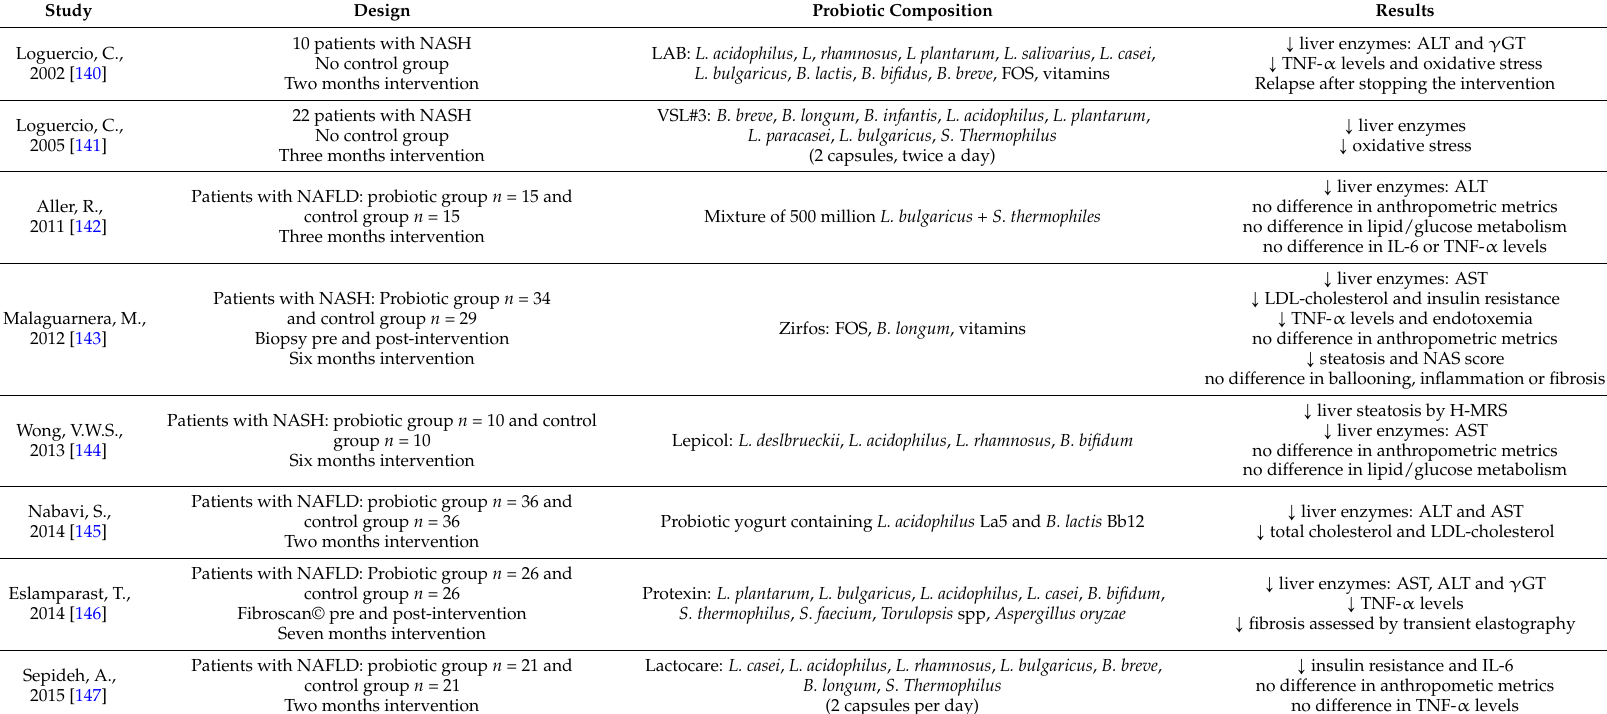
Table 2. Studies evaluating the therapeutic role of probiotics in human